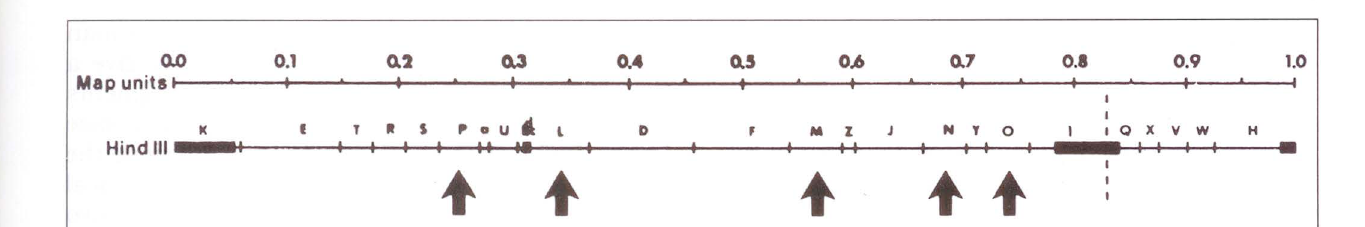
Figure 1) Position of the Hind III-L (12.0 kb). -M (11 .0 kb), -N (9.0 kb), -0 (8.9 kb) and -P (8.0 kb) restrictionjragments within the human cytomegalovirus genome. Thickened areas represent the inverted repeats of the long and short invertible genome components (22). The point at which inversion occurs is indicated by the dotted line